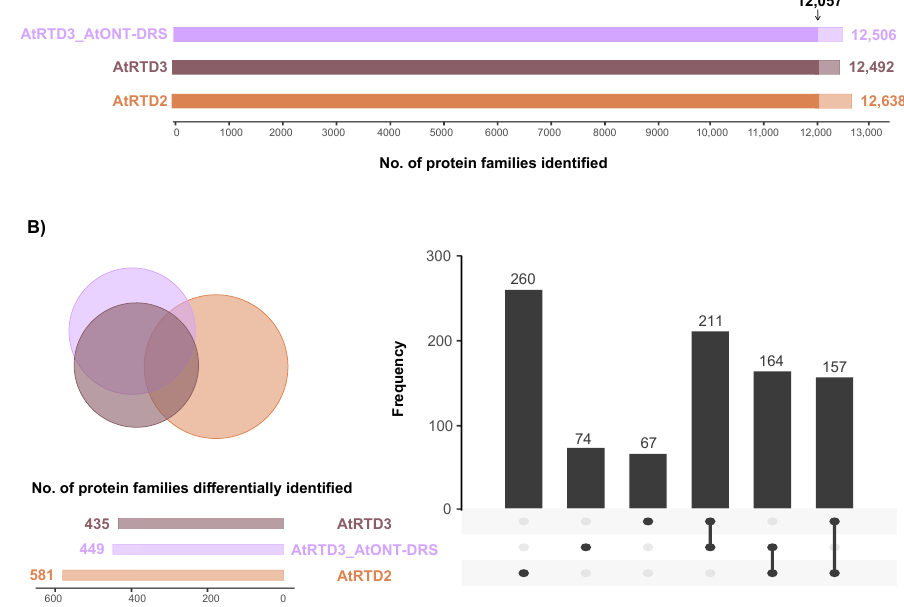
Figure 2. Identification of protein families in proteomics data from senescent leaves in Arabidopsis. ( A ) Total number of protein families identified with each database. The arrow marks the protein families identified in common by the three databases. ( B ) Venn diagram and UpSet plot showing the overlap between the protein families identified with each database, excluding the 12,057 families identified by the three of